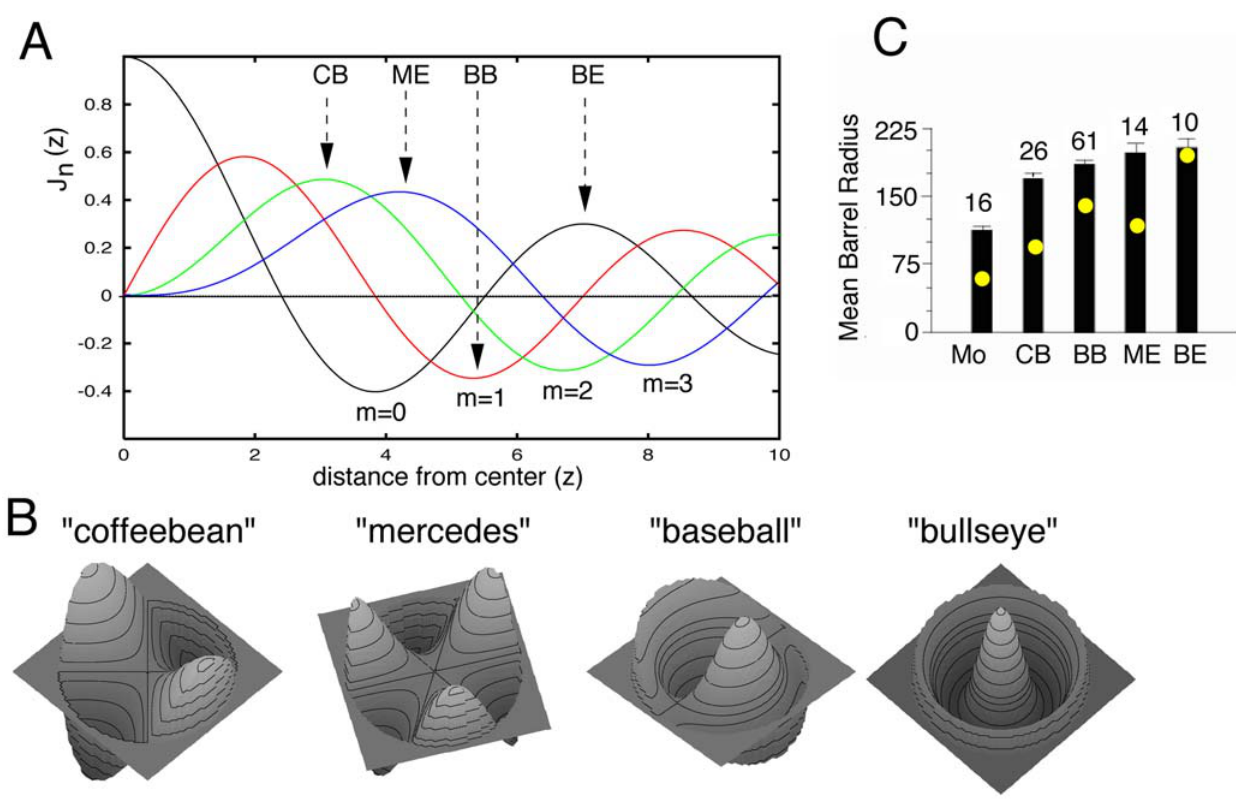
Figure 3. Patterns on a disk. A) Plots of the first 4 (denoted by m ~ 0,1,2,3 ) Bessel functions, J n ( z ) as a function of distance (z) from disk center. Arrowheads delineate locations of dJ n = dz ~ 0 , corresponding to the minimal disk size where a given pattern will first emerge. B) Three dimensional views of the eigenfunctions showing their correspondence to the four basic subbarrel patterns. C) Mean radius of barrels containing particular subbarrel patterns (Mo(use) = no pattern). Numbers above each bar indicate number of barrels measured. Dots within each bar indicate the theoretical size of the barrel expected to contain that subbarrel pattern.